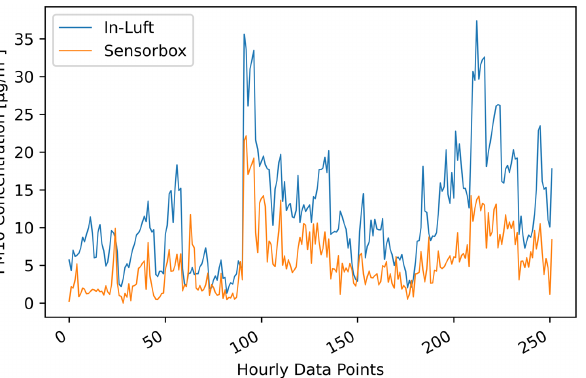
Figure 13. PM 10 hourly mean data recorded with mobile pilot sensor-box 6 located in Luzern in the period from 7 July 2021 to 2 September 2021, compared to hourly mean data recorded at the in-luft station located in Luzern. Data gaps are removed from the graph. Number of mean hourly values: 252; Resulting correlations: R P = 0.83, R S =